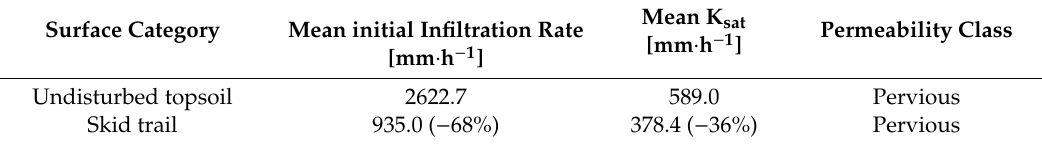
Table 4. Mean initial infiltration rate and mean saturated hydraulic conductivity (K sat ), aggregated by surface category. Relative deviation on skid trails noted in brackets.